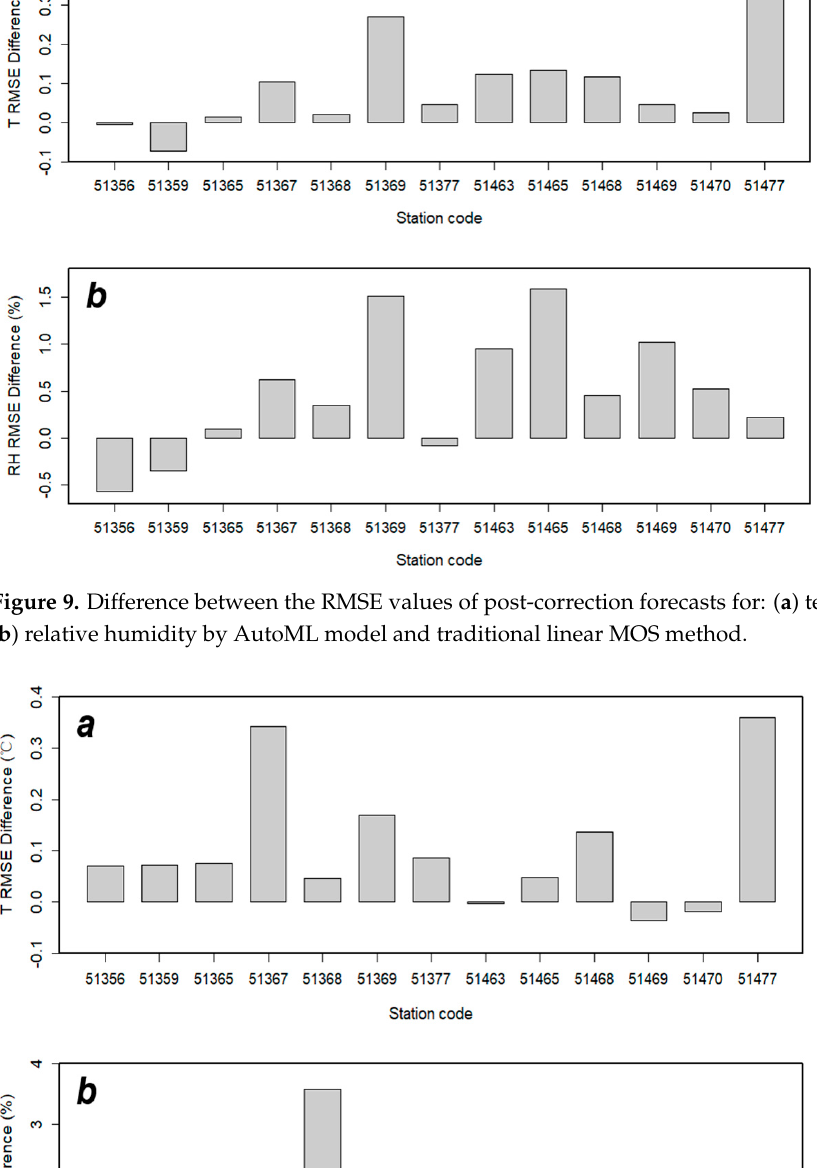
Figure 8. Difference between the RMSE values of post-correction forecasts for: ( a ) temperature and ( b ) relative humidity by AutoML model and random forest model.